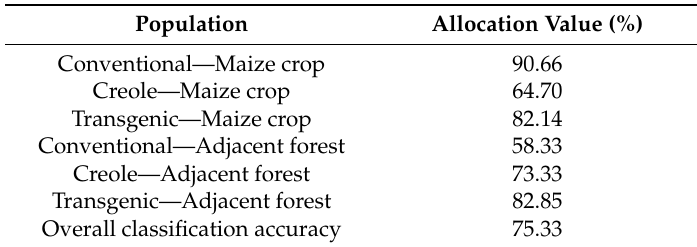
Table 1. Percentage of correct classification of C . quinquemaculatus populations based on body morphology and discriminant analysis